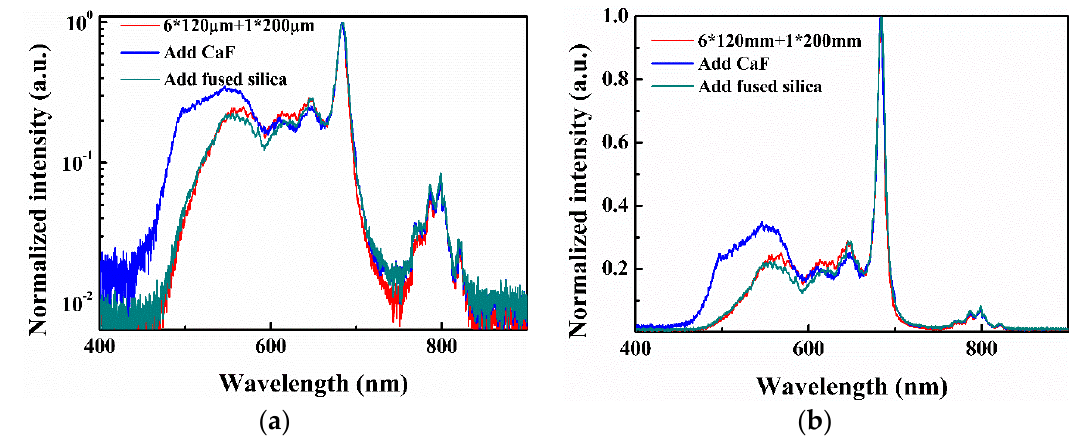
Figure 5. SC spectrum after the laser beam propagated through a set of mixed thin plates with different materials and thickness. ( a ) Spectra on a log scale; ( b ) Spectra on a linear scale.